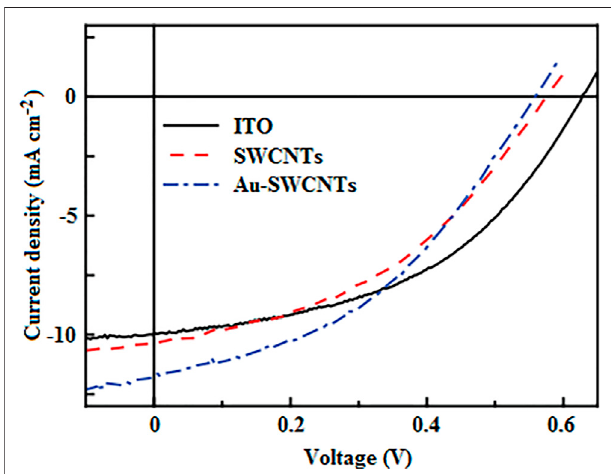
FIGURE 4 | J-V characteristics of conventional OSCs employing ITO, SWCNTs, and Au-SWCNTs as anodes. Adapted with permission (Fan et al., 2017). Copyright 2017, Chinese Physical Society and Institute of